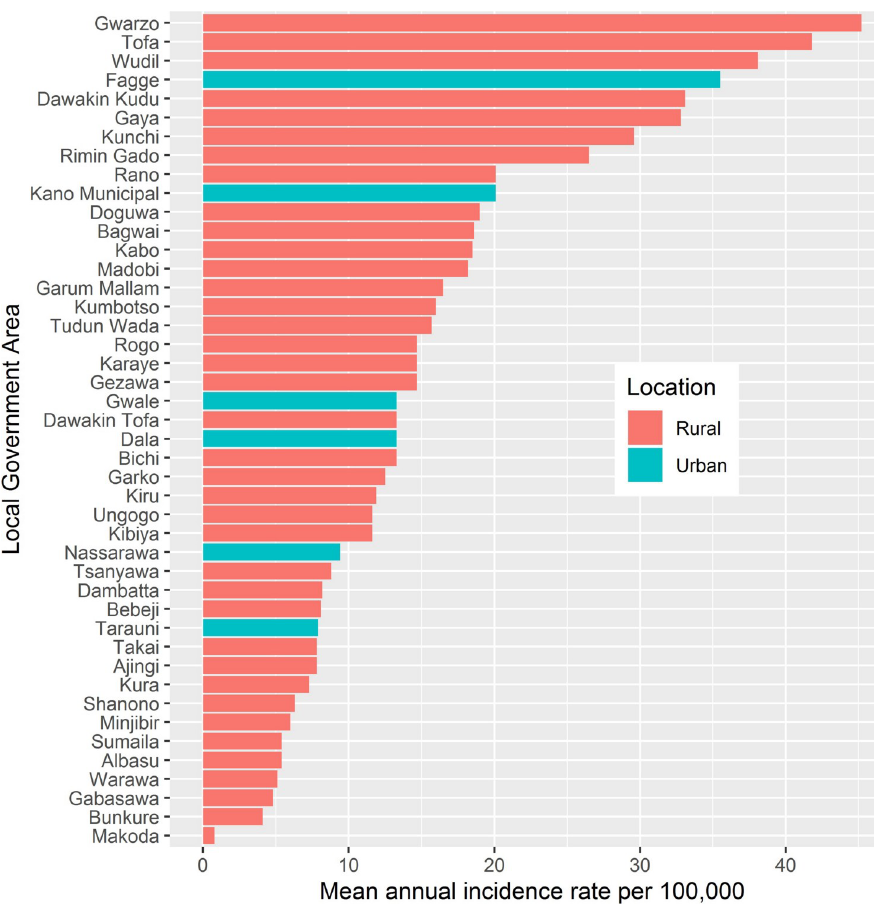
Fig 6. Distribution of mean annual incidence of cholera by urban and rural Local Government Areas (LGAs), 2010–2019. From top to bottom, the top three ranked LGAs with highest burden of cholera are rural LGAs (Gwarzo, Tofa and Wudil) while the first urban LGA (Fagge) with elevated burden of cholera comes at the fourth position. In the ten years of data analyzed, cholera occurs predominantly in rural 75% (6/44) compared to urban